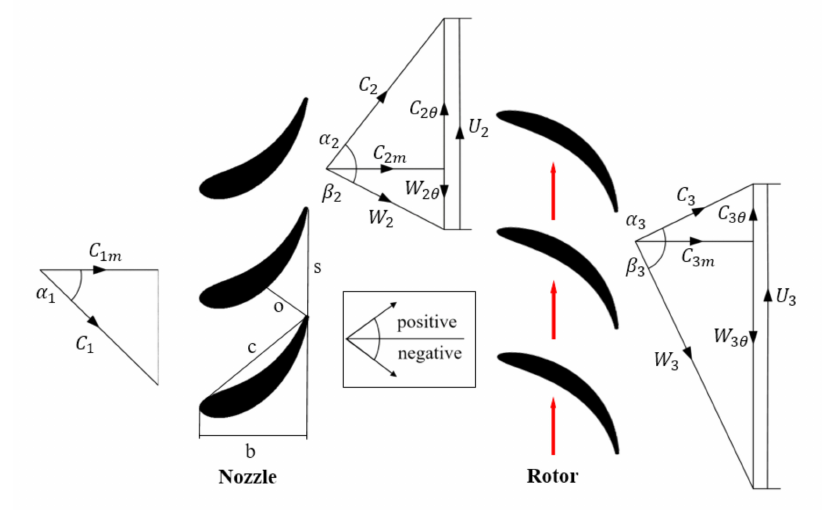
Figure 2. Schematic of a turbine stage velocity triangle for a radial outflow turbine (Adapted from